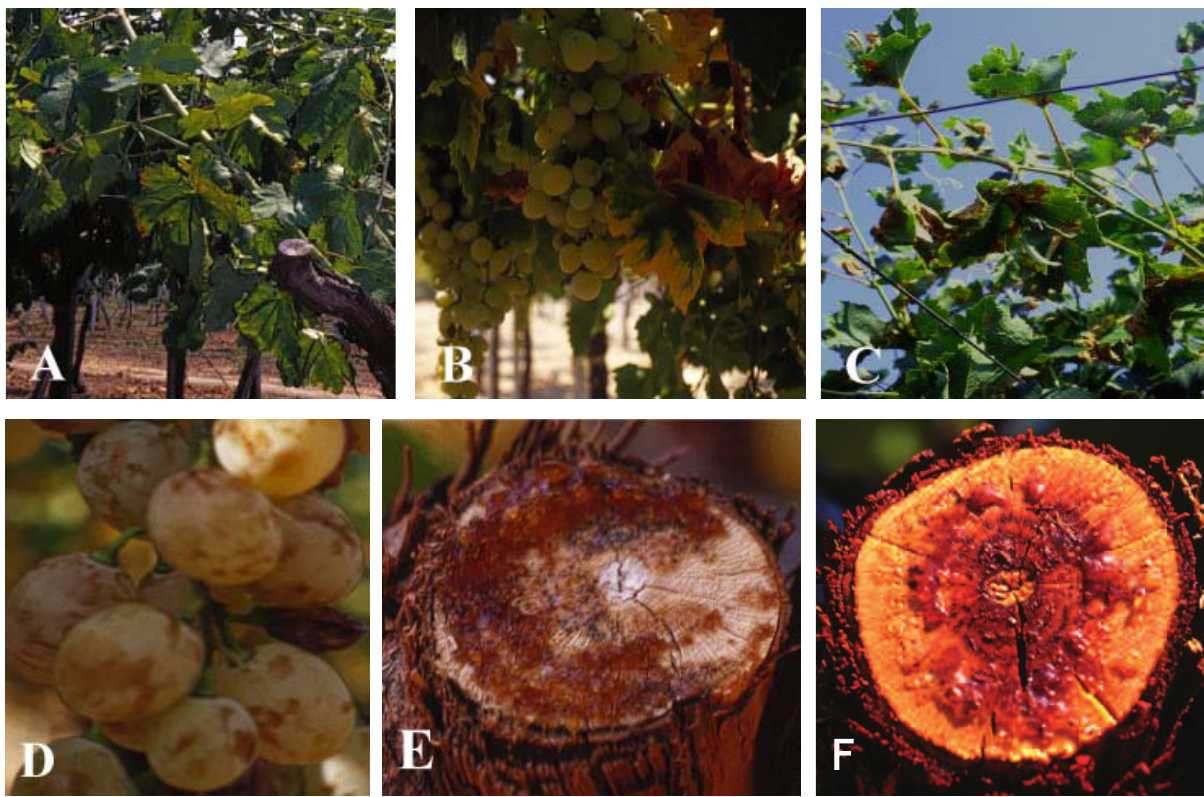
Fig. 4. Symptoms on leaves, berries and branches of grapevines cv. Matilde inoculated with: A. Phaeomoniella chlamydospora ( Pch ); B. Phaeoacremonium aleophilum ( Pal ); C. Pal , Pch ; D. Pal ; E. Pal ⇑ , Fomitiporia punctata ( Fop ) ⇓ ; F. [ Pal, Pch ] ⇑ , Fop ⇓ . With dual or triple inoculations, one fungus was inoculated either above ( ⇑ ) or below ( ⇓